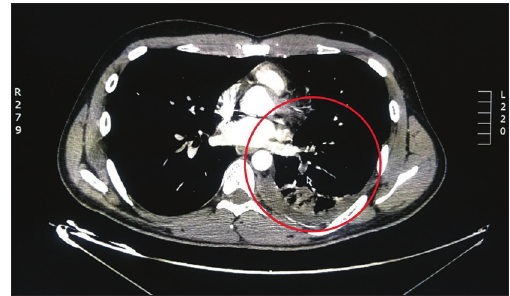
FIGURE 3. Chest CT – May 16, 2016. 2. Cross-section.